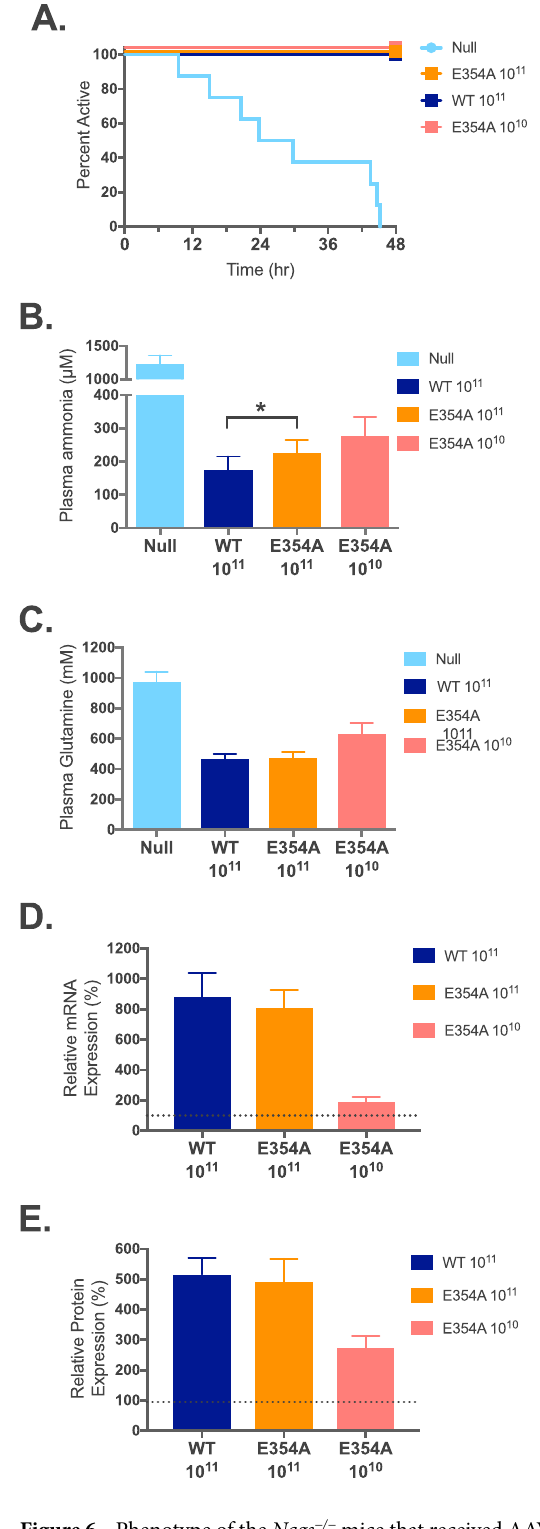
Figure 6. Phenotype of the Nags −/− mice that received AAV2/8NAGS.mNAGS-E354A gene therapy. Duration of activity on the voluntary wheel ( A ), plasma ammonia ( B ) and glutamine ( C ) concentrations, abundance of the liver NAGS mRNA ( D ) and protein ( E ) after withdrawal of NCG. Each column represents a mean and its associated SEM of measurements in n = 8 animals; 100% is the mean value for four Nags + / +